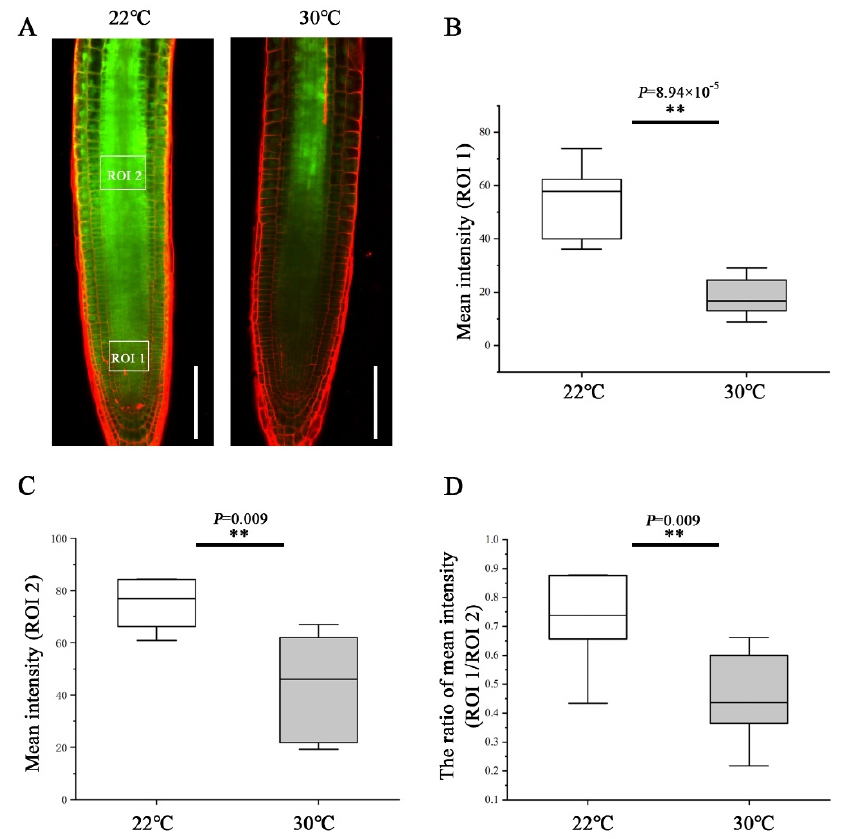
Figure 2. Heat stress inhibits phloem unloading in the root tips. ( A ) Comparison of the phloem unloading in the root of pSUC2::GFP-expressing 5-day-old seedlings at 48 h after being transferred to 22 ◦ C and 30 ◦ C. Scale bars = 100 µ m. ( B ) Quantification of fluorescence intensity in an area of 50 × 40 µ m 2 (ROI1, 50 µ m away from quiescent center (QC) in the central root meristem). ( C ) Quantification of fluorescence intensity in an area of 50 × 40 µ m 2 (ROI2, 300 µ m away from QC in the stele). ( D ) Quantification the unloading capability from the phloem into the meristem by the ratio of GFP fluorescence intensity of an ROI1 relative to an ROI2. In the box plots ( B – D ), the boxes indicate the first and third quartiles, and the whiskers indicate the minimum and maximum values. The black lines within the boxes indicate the median values. ** p < 0.01 (two-tailed, two-sample t -test).